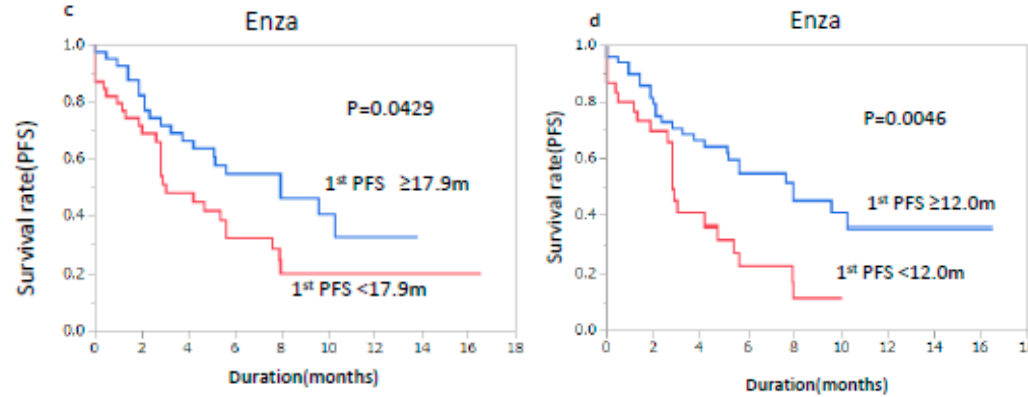
Figure 3. Progression-free survival according to the progression-free survival of first-line therapy. ( a ) Progression-free survival according to a median progression-free survival of first-line therapy <15.4 months or ≥ 15.4 months as the cut-off values in enzalutamide- and abiraterone-treated patients. (m, months). ( b ) Progression-free survival according to the progression-free survival of first-line therapy <12.0 months or ≥ 12.0 months as the cut-off values in enzalutamide-treated patients. ( c ) Progression-free survival according to a median progression-free survival of first-line therapy <17.9 months or ≥ 17.9 months as the cut-off values in enzalutamide-treated patients. ( d ) Progression-free survival according to a median progression-free survival of first-line therapy <12.6 months or ≥ 12.6 months as the cut-off values in abiraterone-treated patients.